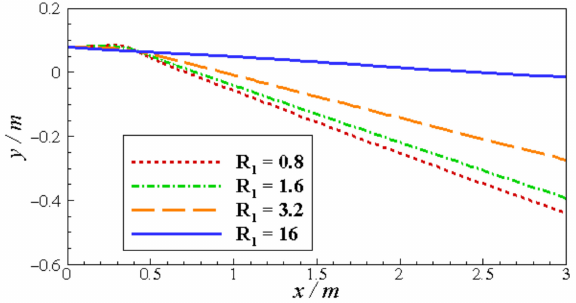
Figure 16. Comparison of the deflections of upper jet boundary at different height-chord